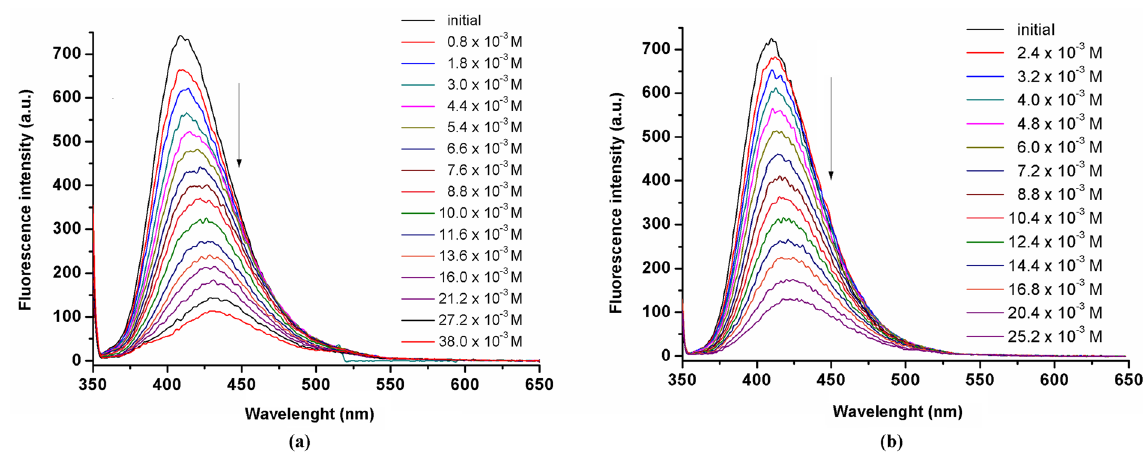
Figure 6. Fluorescence spectra of A-D-Phe-co-D-MABU-F (plot a) and A-L-Phe-co-L-MABU-F (plot b) in DMF solution, in the absence and the presence of HCl 10 -1 M at different concentrations; λ = 340 ex